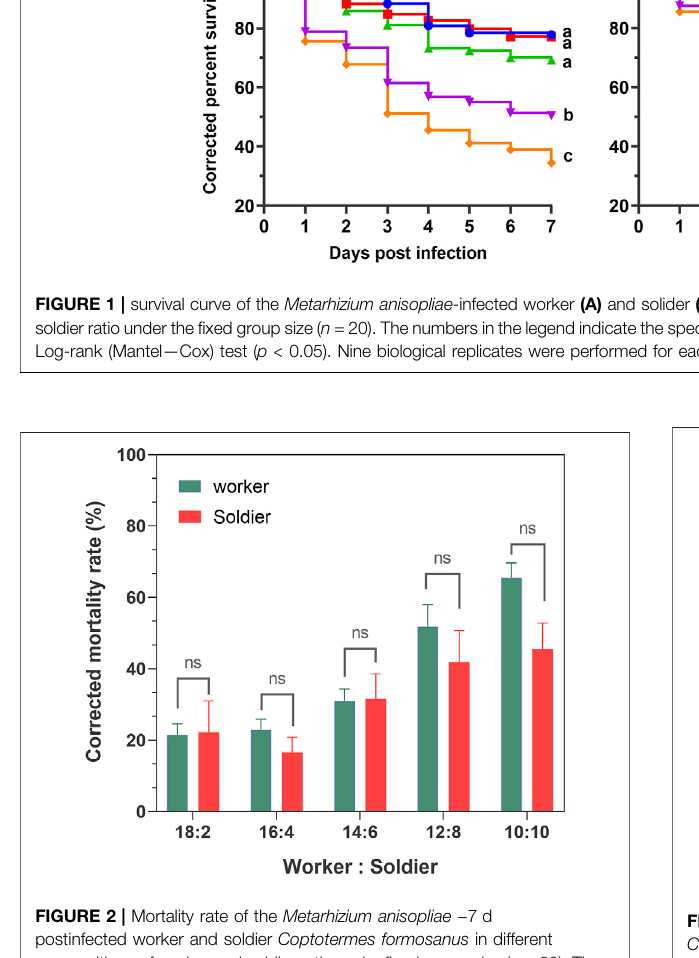
control) in the groups 16:4 ( p = 0.002) and 14:6 ( p = 0.01) of FS,